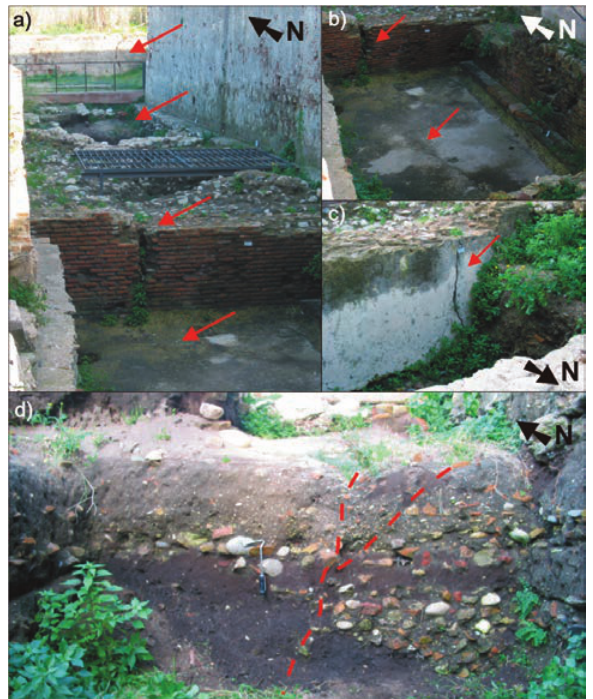
Figure 7. NE wall of the excavation at Torre degli Inglesi (see Fig- ure 6 for location). The material infilling the cisterns dated with both archaeological and radiometric analysis shows age between 1st-3th century. Dashed red line and arrows highlight a fracture related to the 1908 earthquake, since it cuts constructions and de- posits of all periods.